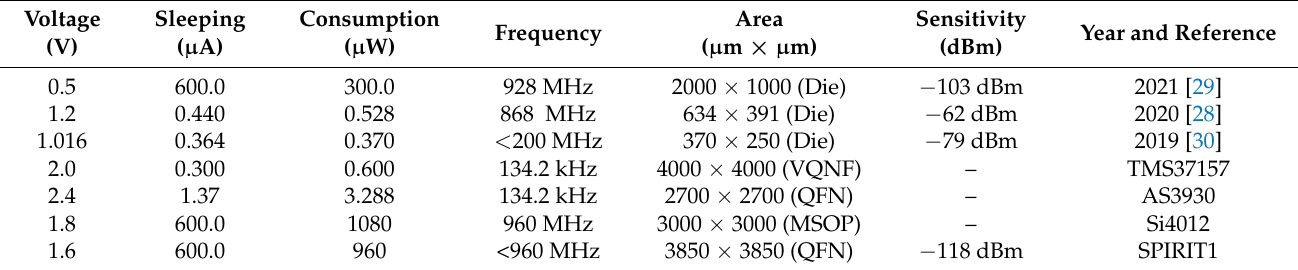
Table 5. Comparison of recent wake up receiver (WUR)